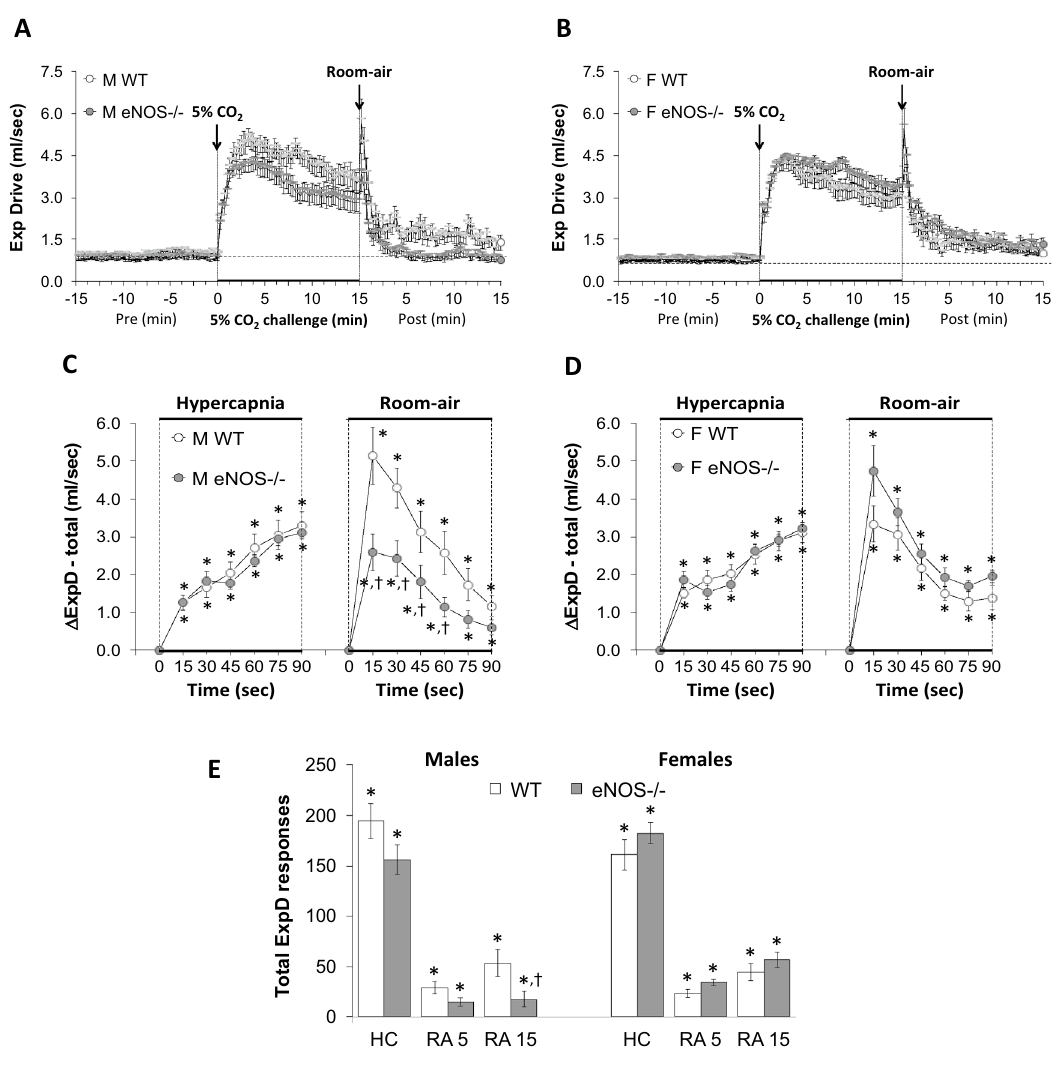
Figure 7. Panels ( A ) and ( B ) Expiratory drive (tidal volume/expiratory time, TV/Te) values before, during a hypercapnic (HC) gas challenge (5% CO 2 , 21% O 2 , 74% N 2 ) and upon return to room-air in male (M) and female (F) wild-type (WT) and eNOS knock-out (eNOS-/-) mice. Panels ( C ) and ( D ) Arithmetic changes in TV/Te in male and female WT and eNOS-/- mice during the first 90 s of exposure to HC challenge and the first 90 s upon return to room-air. Panel ( E ) Total changes in TV/Te in male and female WT and eNOS-/- mice during HC challenge and during the first 5 min (RA5) and entire 15 min (RA15) return to room-air. The data are presented as mean ± SEM. * P < 0.05, significant change from pre-values. † P < 0.05, eNOS-/- versus WT within each